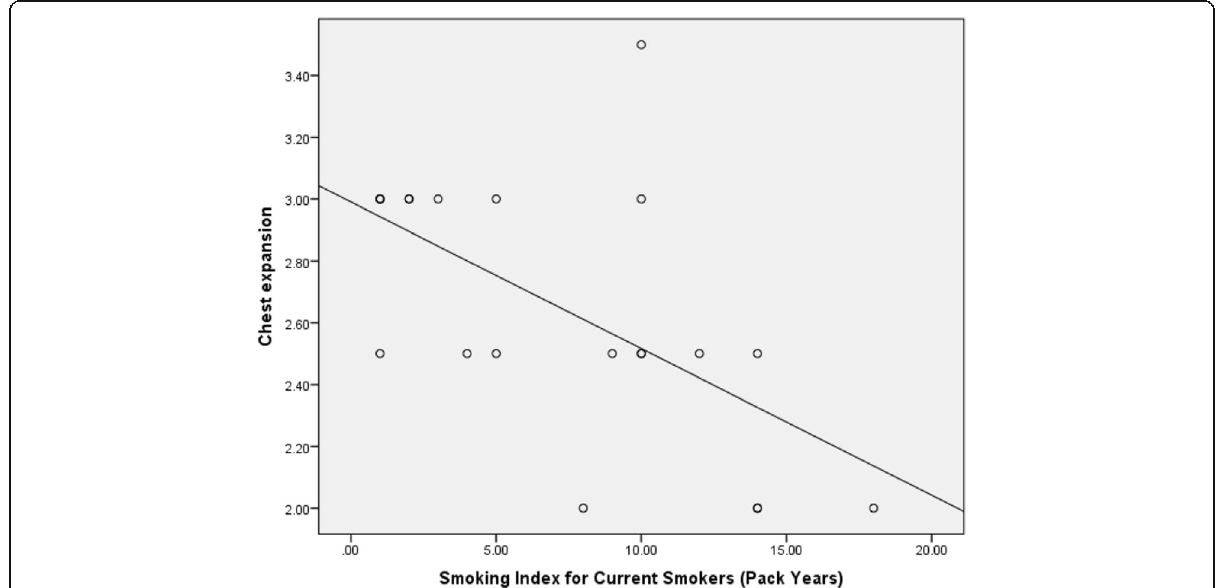
Fig. 4 Correlation between smoking index and chest expansion in AS